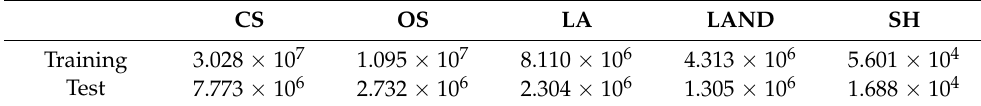
Table 3. Number of pixel samples of different classes.